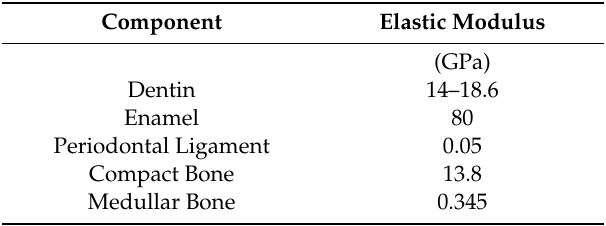
Table 1. Elastic Modulus of teeth’s